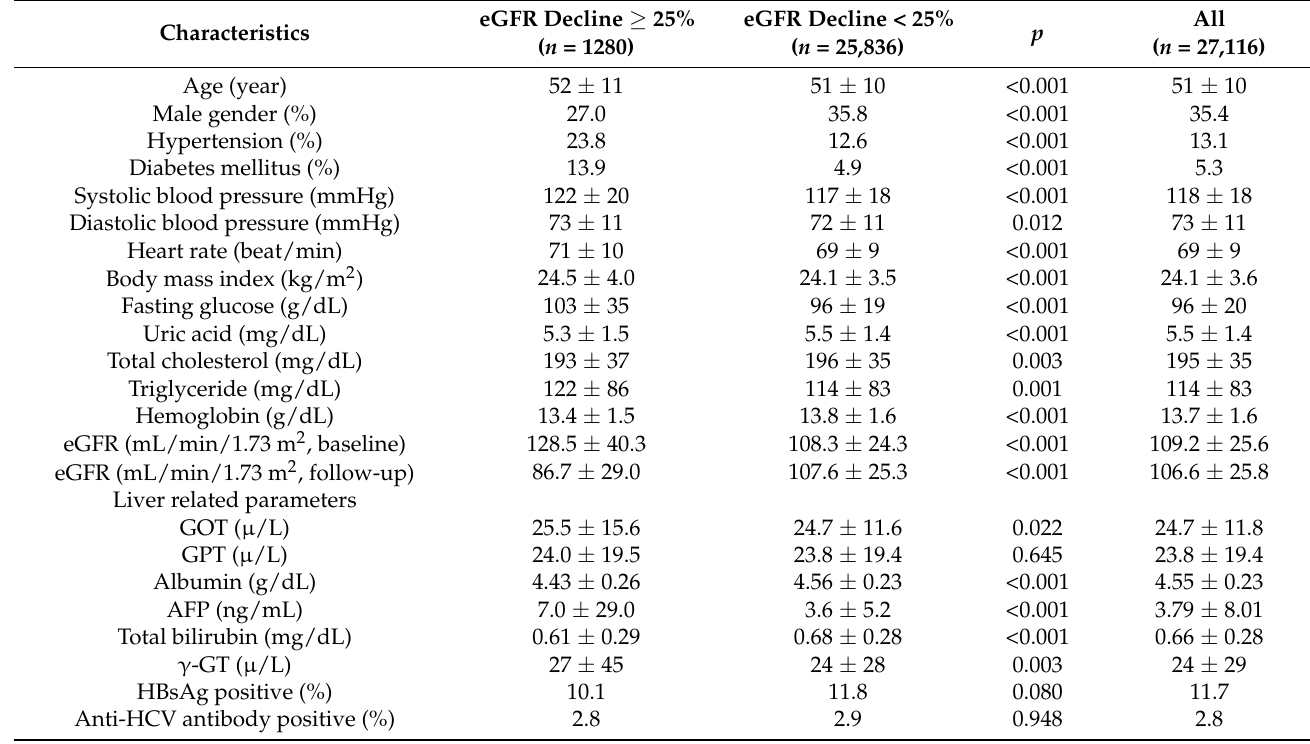
Table 1. Comparison of baseline characteristics between participants with eGFR decline of ≥ 25% and <25%.